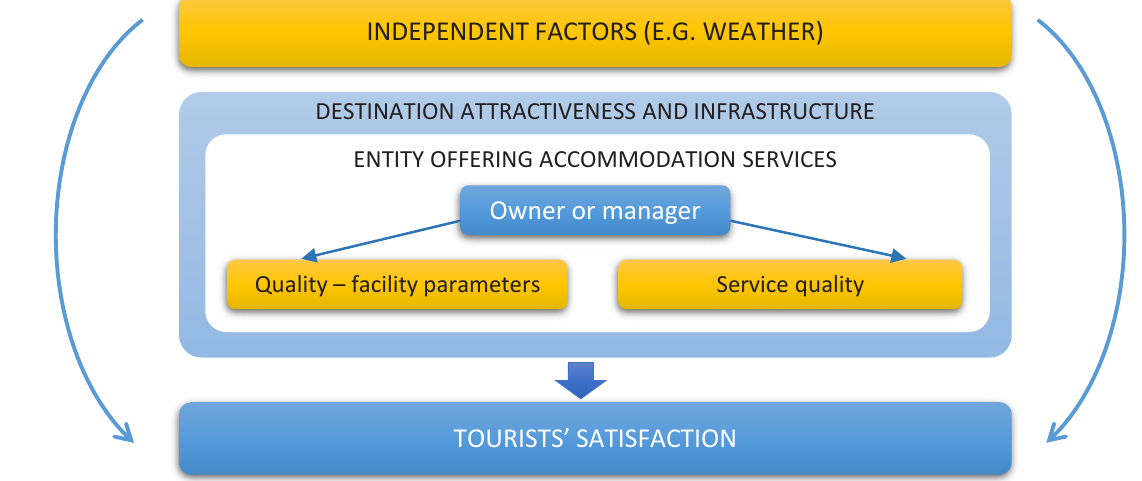
Figure 1. A model of creating value for